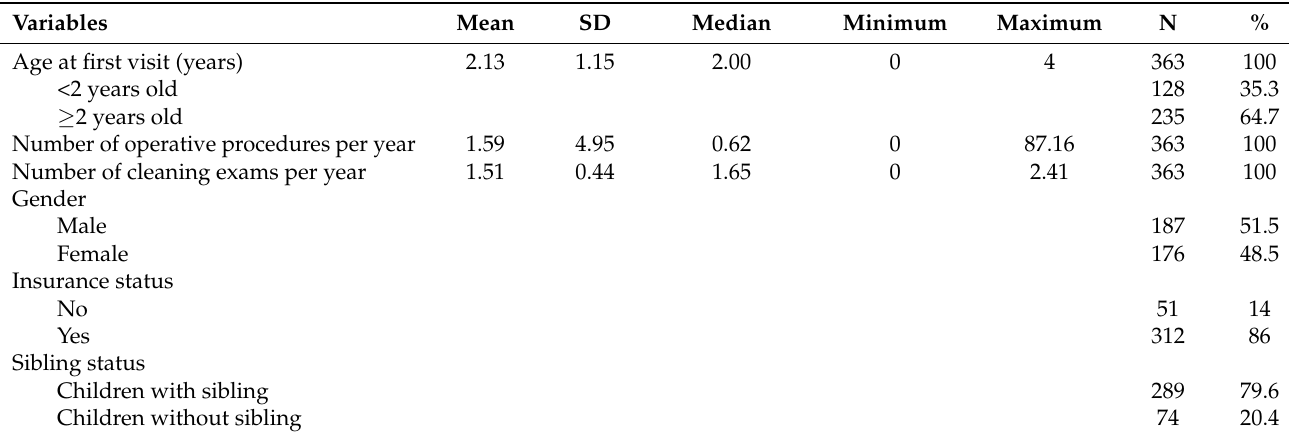
Table 1. Demographic characteristics (N =